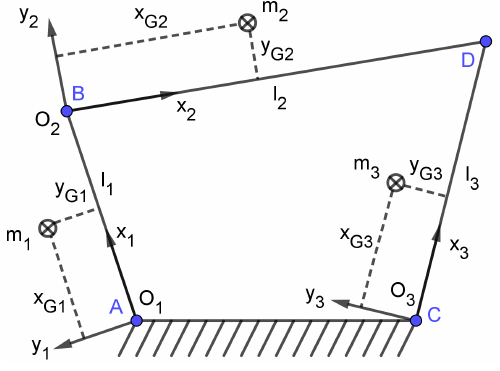
Figure 1. Original Four-bar linkage.